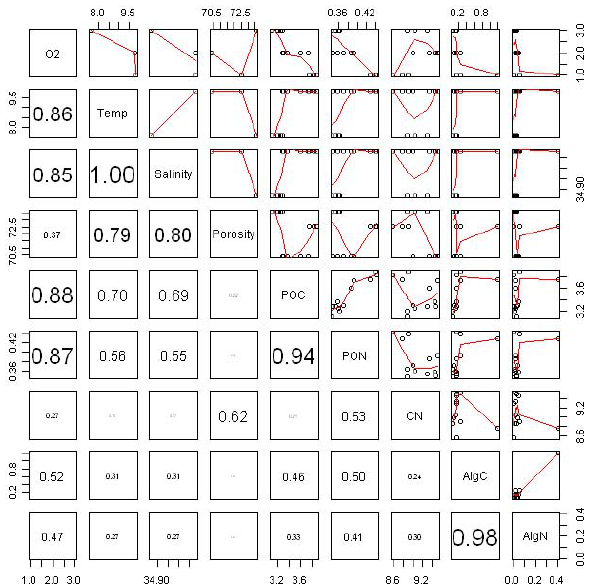
Fig. A1. Paired Scatterplots of Environmental Data, showing the level of correlation between variables as the Spearman’s rank cor- relation coefficient.